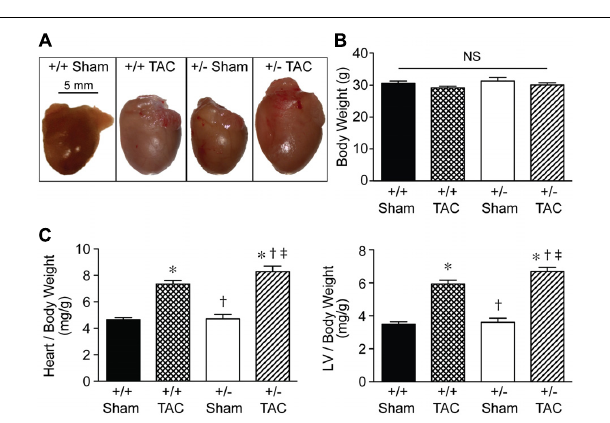
FIGURE 5 | Heart size and cardiac hypertrophy of Speg + / − mice post-TAC. Transverse aortic constriction (TAC) or sham surgery (sham) was performed on 10-week old Speg wild type (+/+) and heterozygous (+/–) mice. (A) Hearts were harvested 4 weeks after TAC, and representative macroscopic images of hearts from each group of mice were obtained. Scale bar represents 5 mm. (B) Total body weights (g) were assessed in each group. (C) Heart and left ventricle (LV) weights were measured, and ratios of heart or LV to body weight were analyzed at 4 weeks (sham, n = 7/group; TAC, n = 7–11/group) after TAC or sham surgery. Analysis by one-way ANOVA ( P < 0.05), with significant comparisons ∗ versus sham of the same group; † versus Speg + / + TAC; ‡ versus Speg + / + sham.